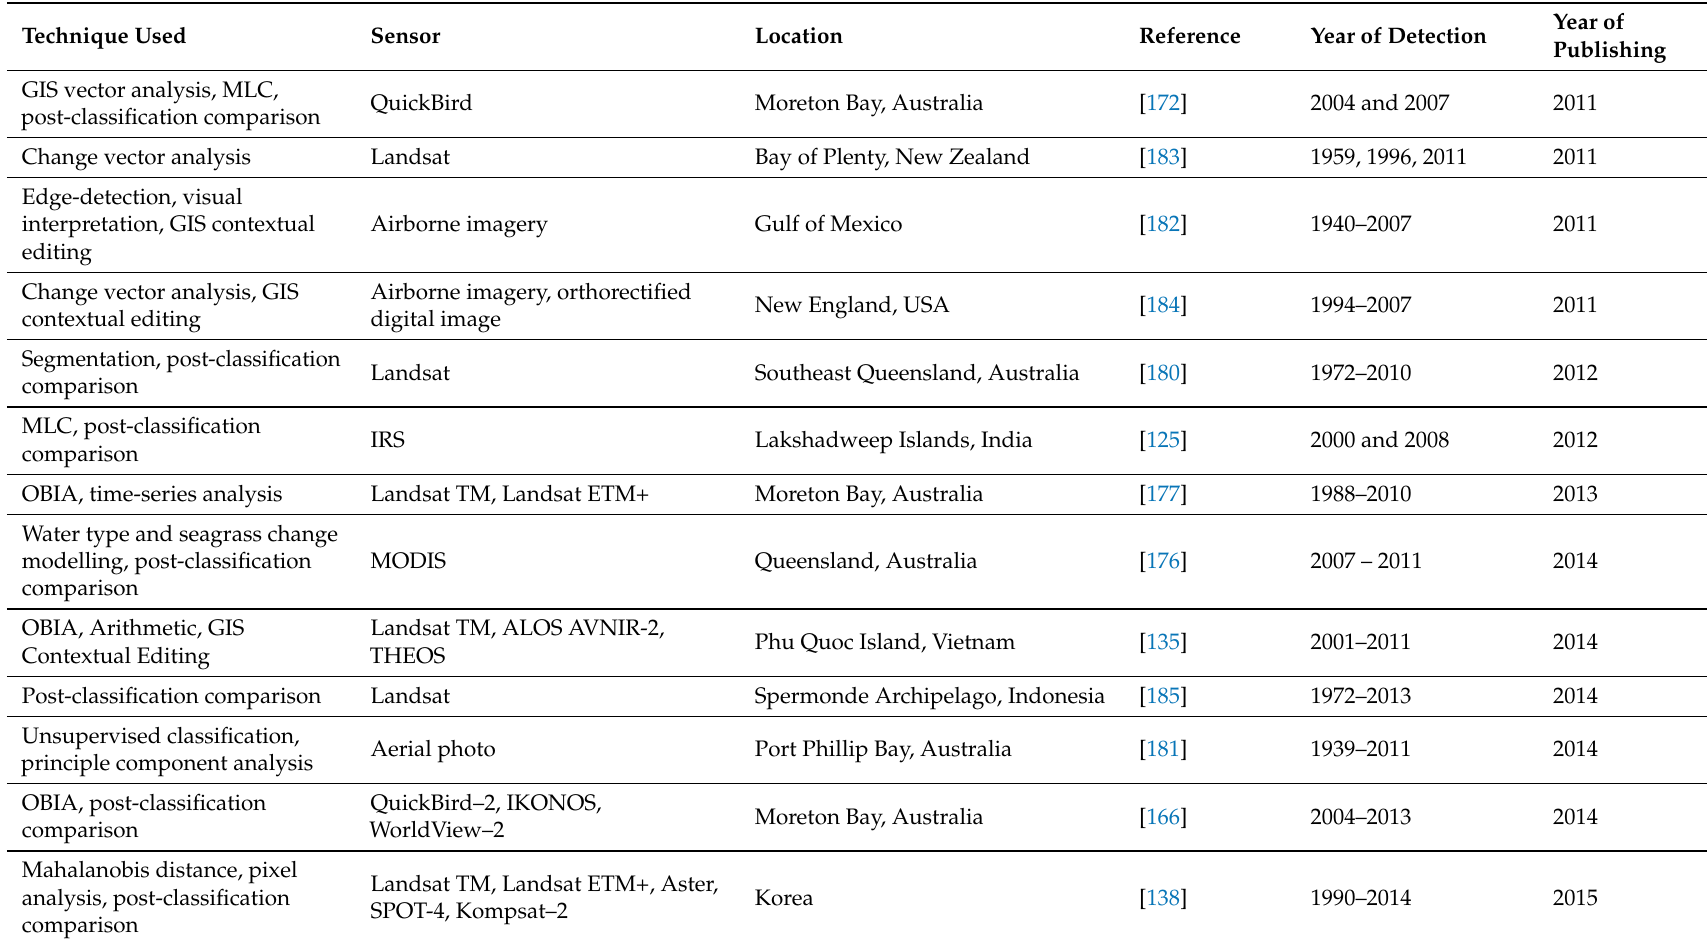
Table 5. Monitoring seagrass change detection using remote sensing